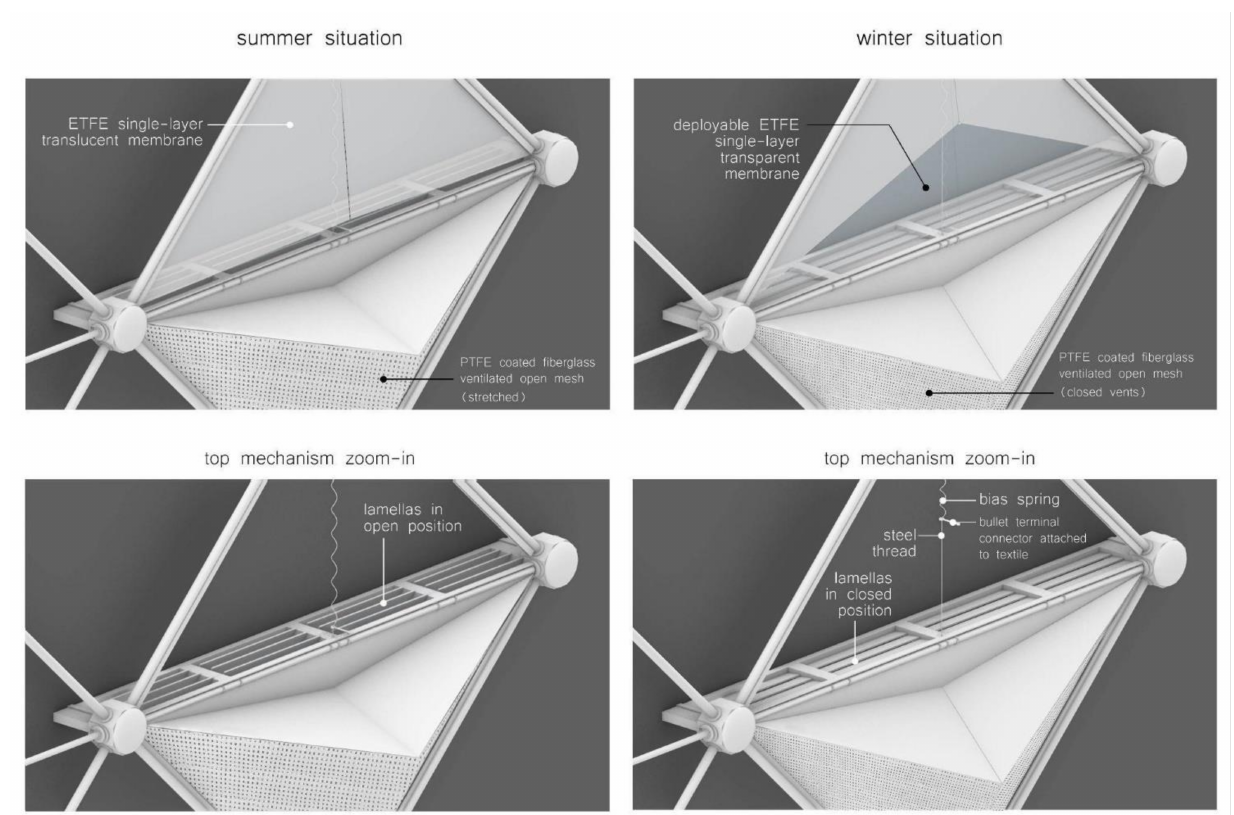
Figure 5. Close-up views of the façade component and mechanism during the summer and winter